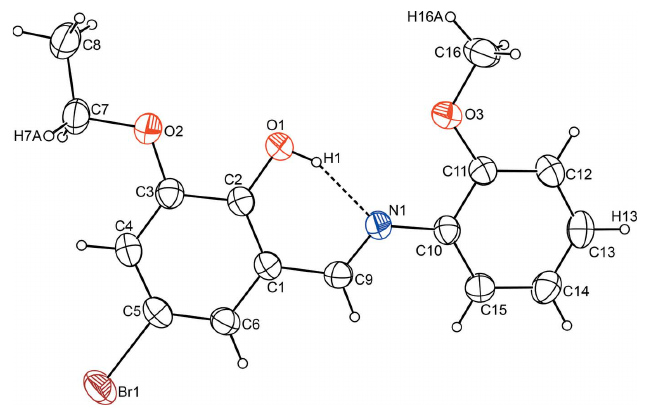
Figure 1 The molecular structure of the title compound, with atom labels and 50% probability displacement ellipsoids for non-H atoms. The dashed line indicates the intramolecular hydrogen